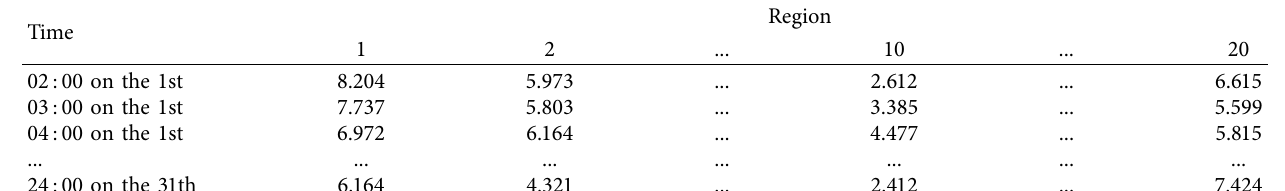
Table 4: Wind speed value of third level fusion